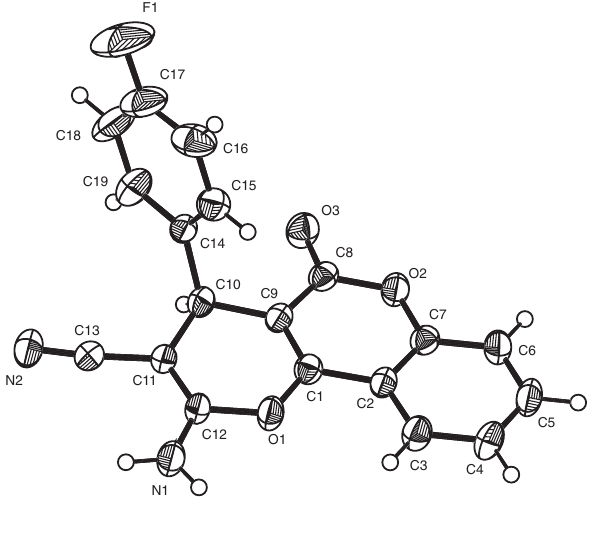
Table 1: Data collection and handling.